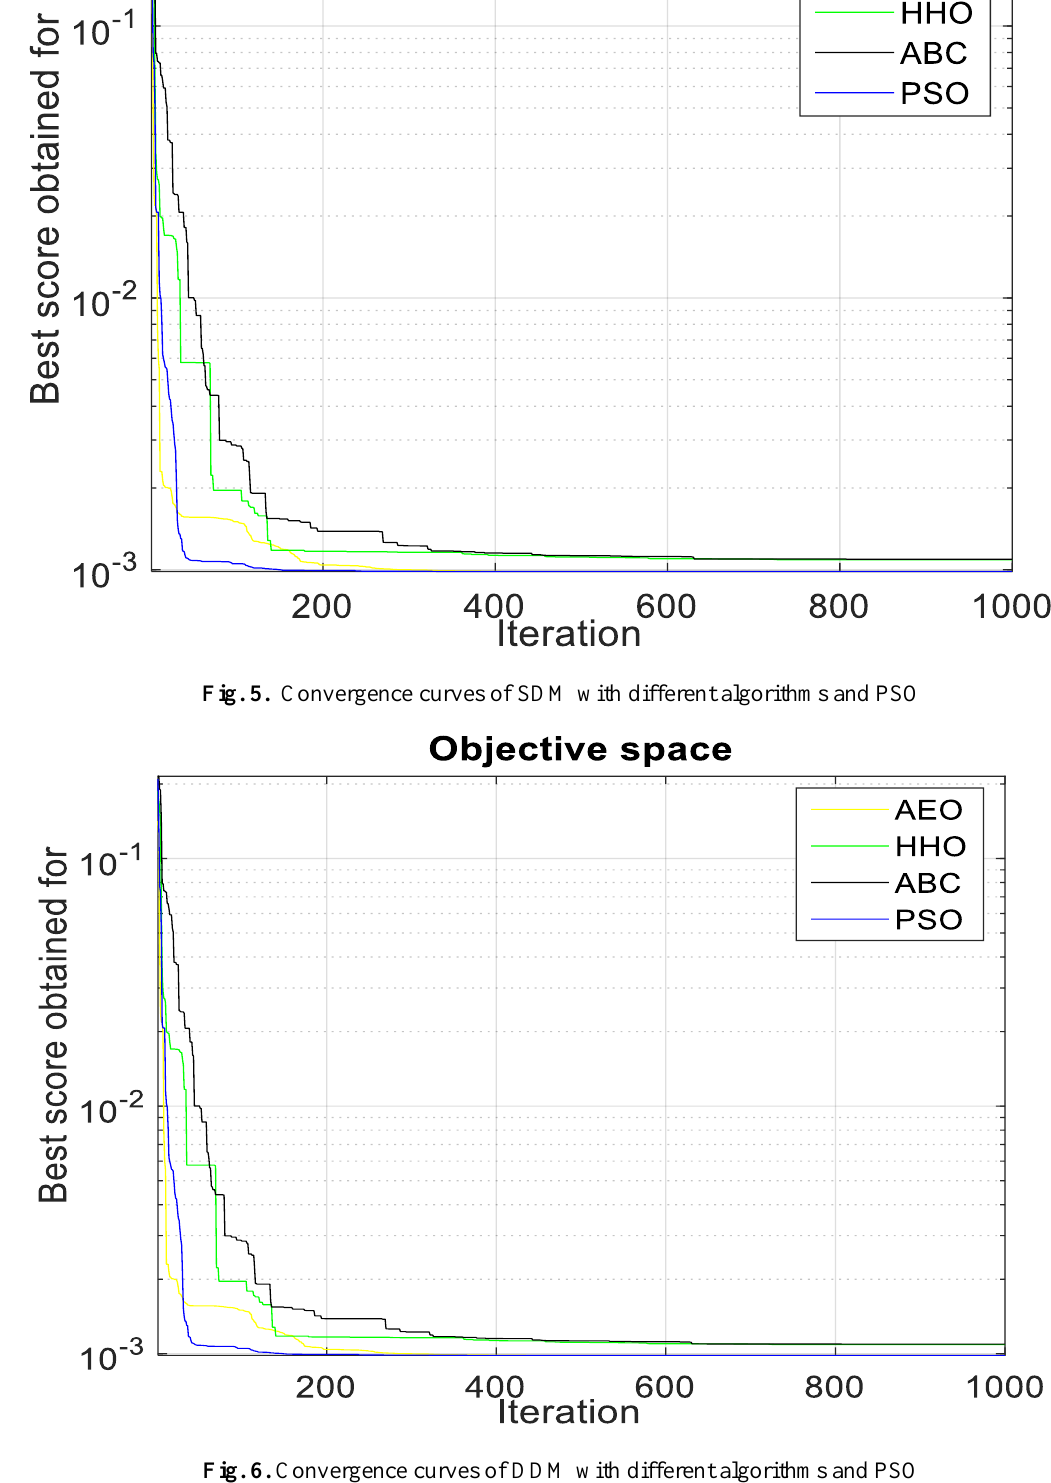
Fig. 6. Convergence curves of DDM with different algorithms and